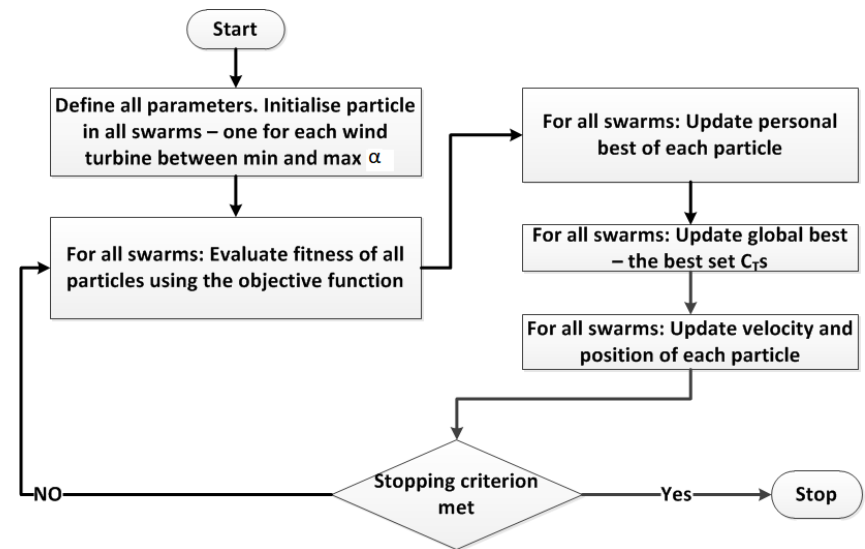
Figure 4. PSO flowchart for estimating optimised α .